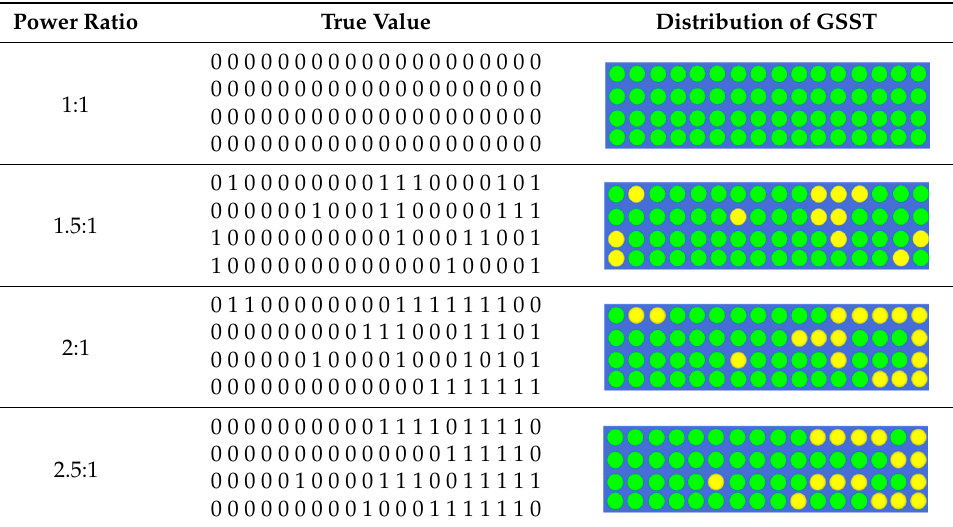
Table 1. Truth tables of different split ratios in 1 × 2 power splitter, the true value ‘1’ corresponding to the yellow spots ( c-GSST state ) .